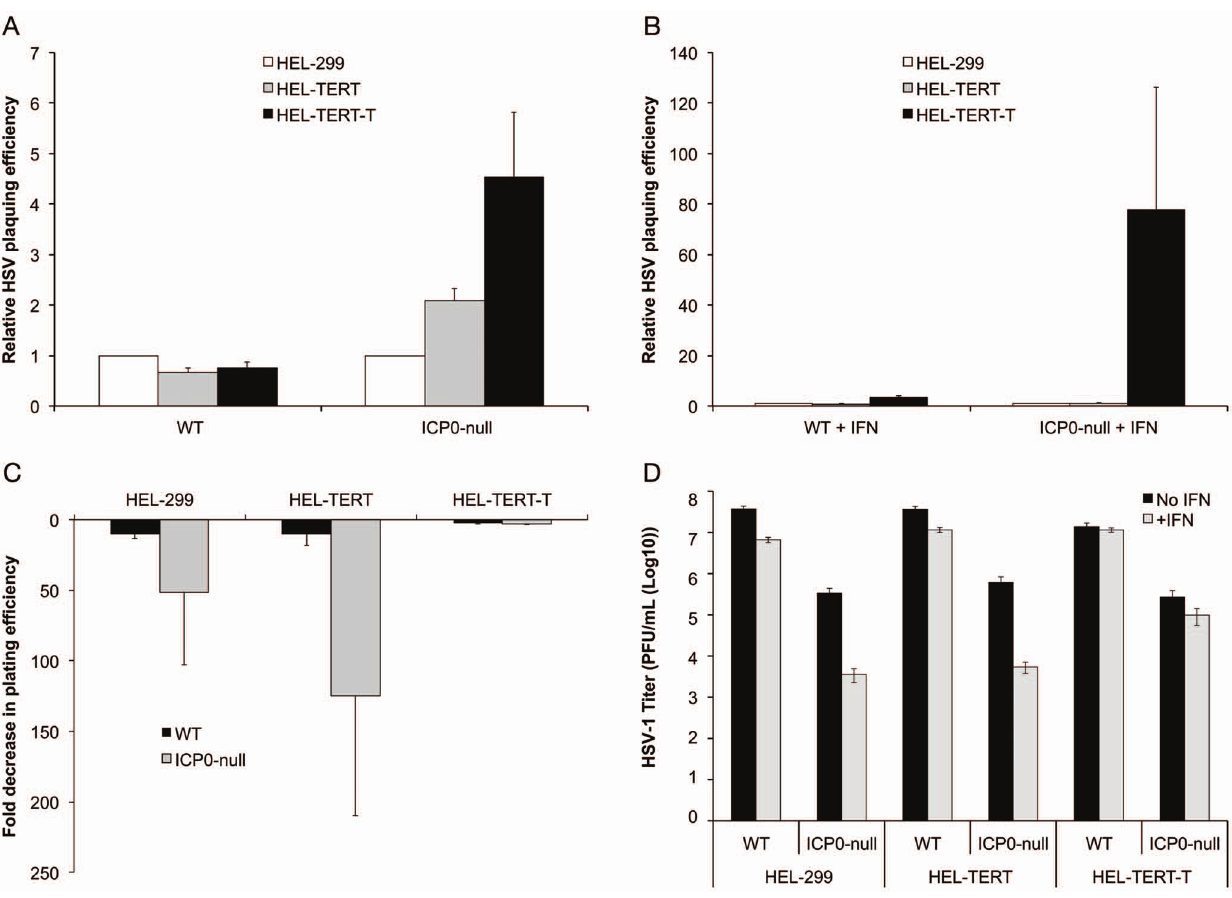
Figure 7. Replication of HSV-1 is diminished by IFN- b in HEL-299 and HEL-TERT but not HEL-TERT-T cells. A and B. HEL-299, HEL-TERT, and HEL-TERT-T cells were mock (A) or pre-treated with IFN- b (1000 U/mL) (B) and were infected 16 h post treatment with 10-fold serially diluted stocks of WT HSV-1 or an ICP0-null mutant. Plaques were visualized by immunohistochemistry 3 days post-infection. An average of three experiments is shown. Data is presented as the ratio of plaques formed on the indicated cell line to that on HEL-299 cells. C. Data generated for A and B, but presented as a ratio of the number of plaques formed on mock-treated cells compared to that on IFN-treated cells. D. HEL-299, HEL-TERT, and HEL- TERT-T cells were mock or pre-treated with IFN- b (1000 U/mL) and were infected (16 h post treatment) with either WT HSV-1 or the ICP0-null mutant at an MOI of 5 PFU/cell. Samples were harvested 24 h post-infection. Viral titers were determined by plaque assays. An average of three experiments is shown. In all cases, error bars represent the standard errors of the means.